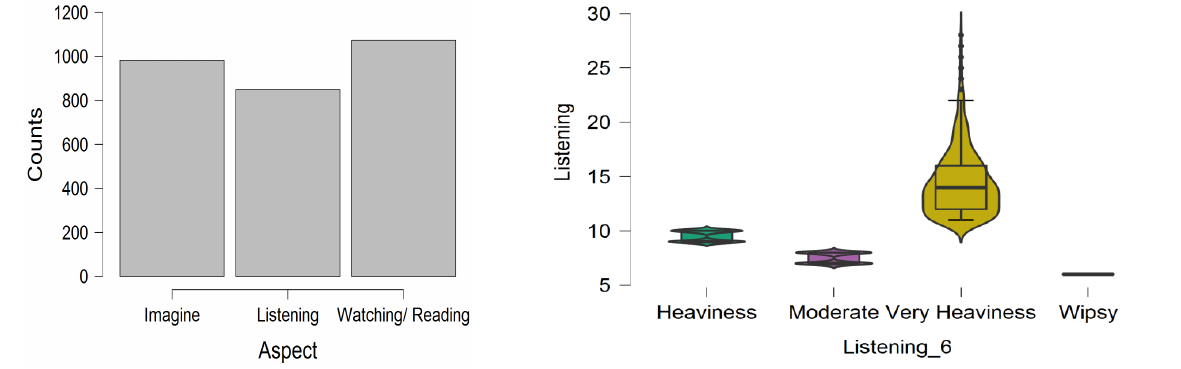
Figure 5. Anxiety by the Aspect Figure 6. Listening